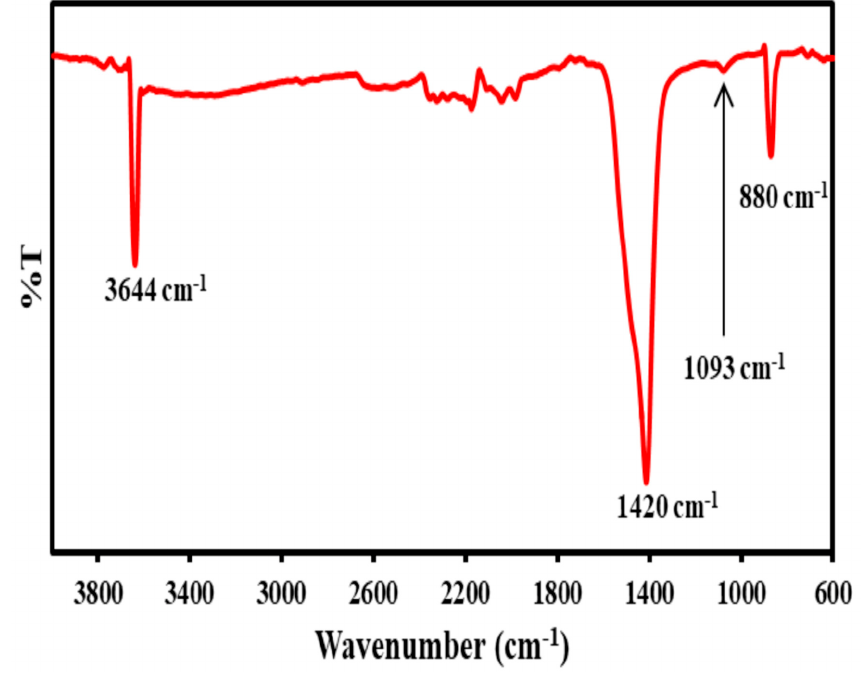
Figure 8. FTIR spectrum of CaCO 3 .